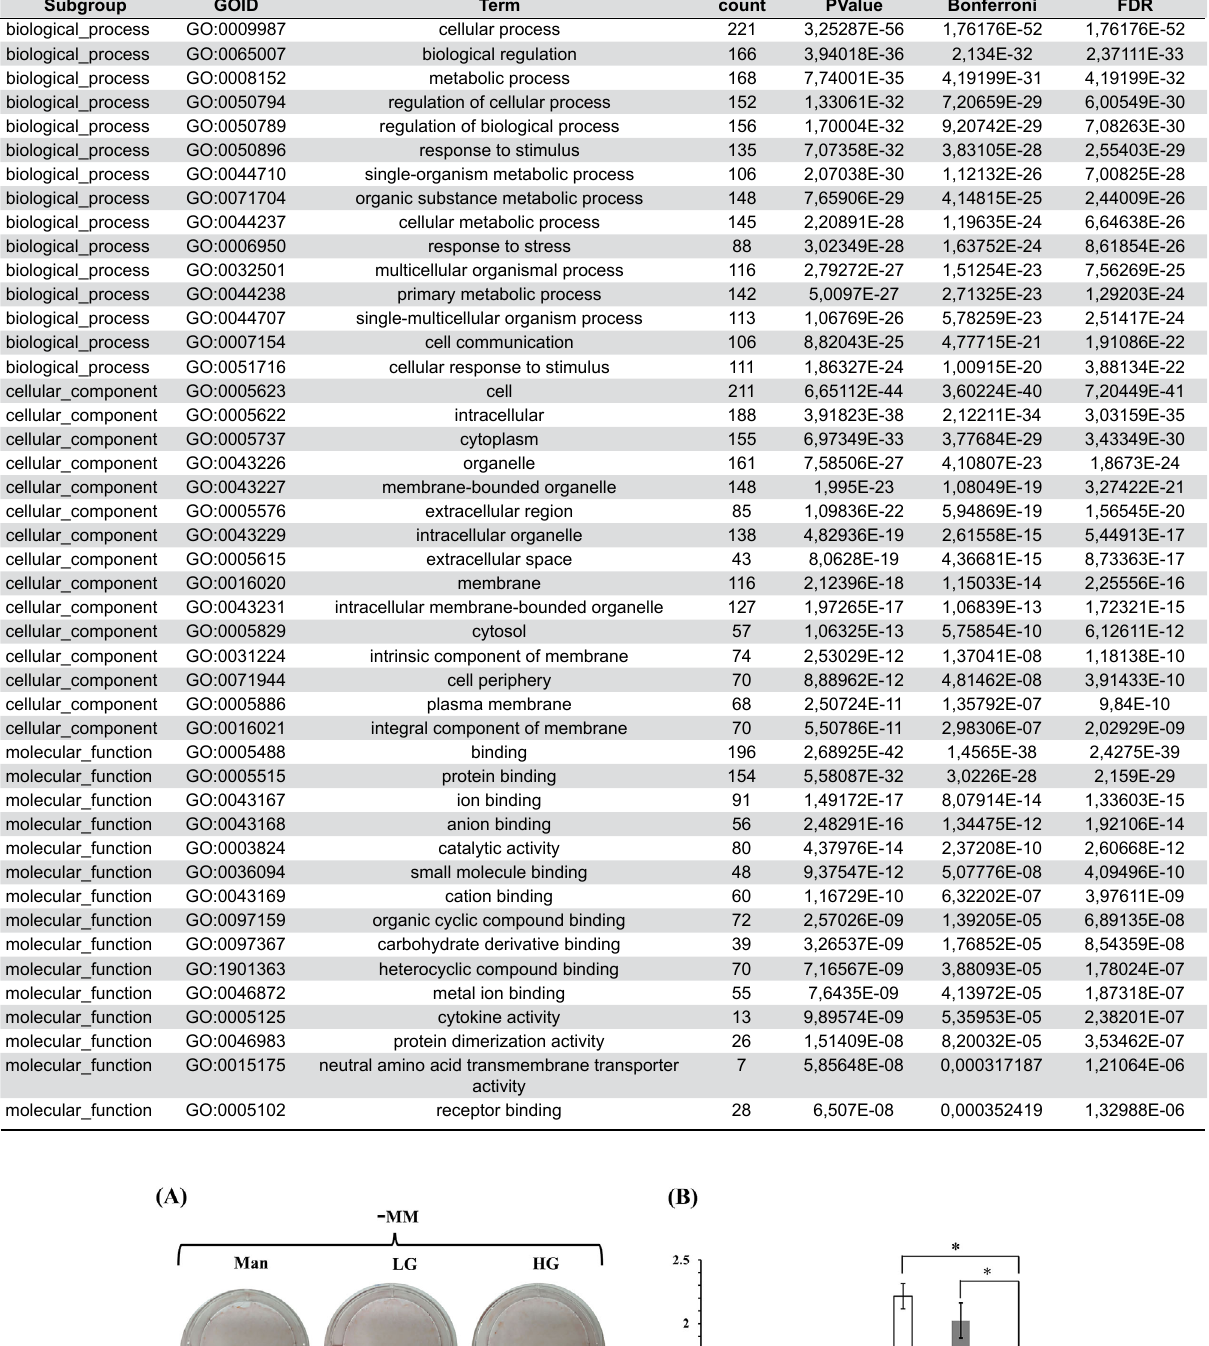
Table S4- The top 15 most enriched GO terms on day 14